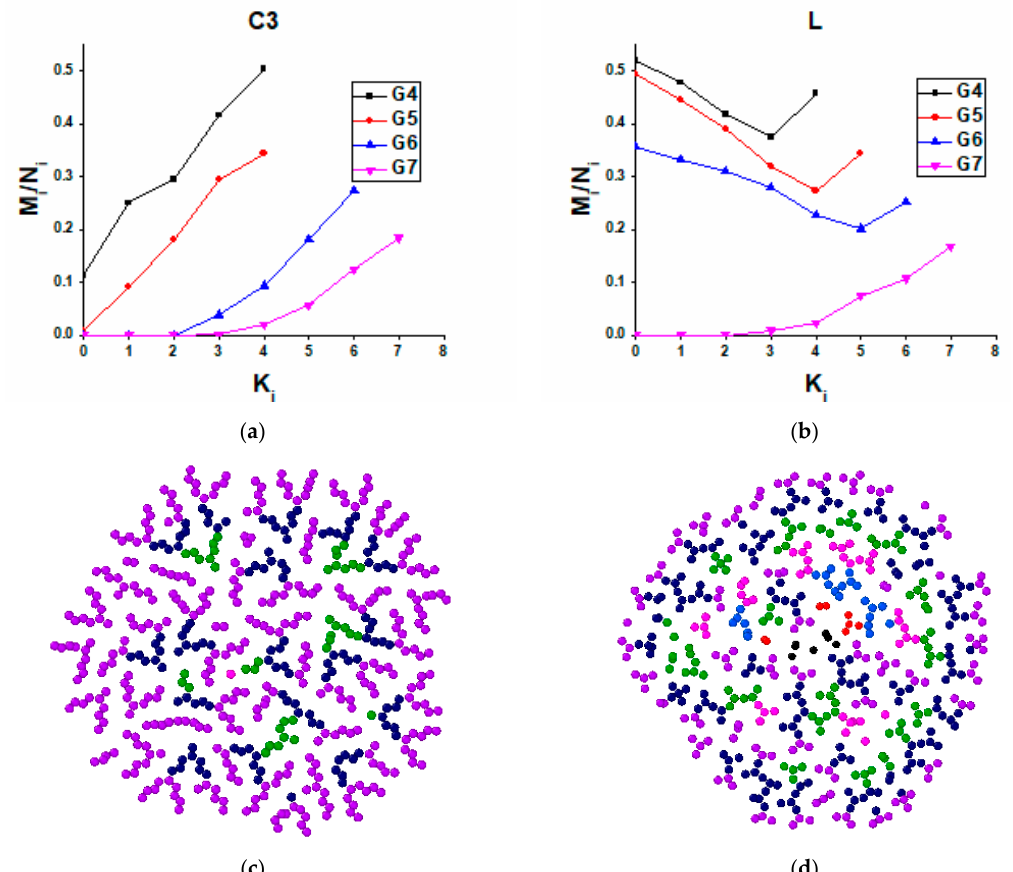
Figure 5. Dependences of the relative number of contacts on the number of the structural layer at ε = 1.5 kcal/mol for ( a ) C4 and ( b ) L -dendrimers. Frontal projections of the adsorption layer of 5 Å for ( c ) C3 and ( d ) L-dendrimers of the sixth generation. Different colors are used for atoms belonging to different structural layers, color palette vs. ki, which are shown in Figure 4a.